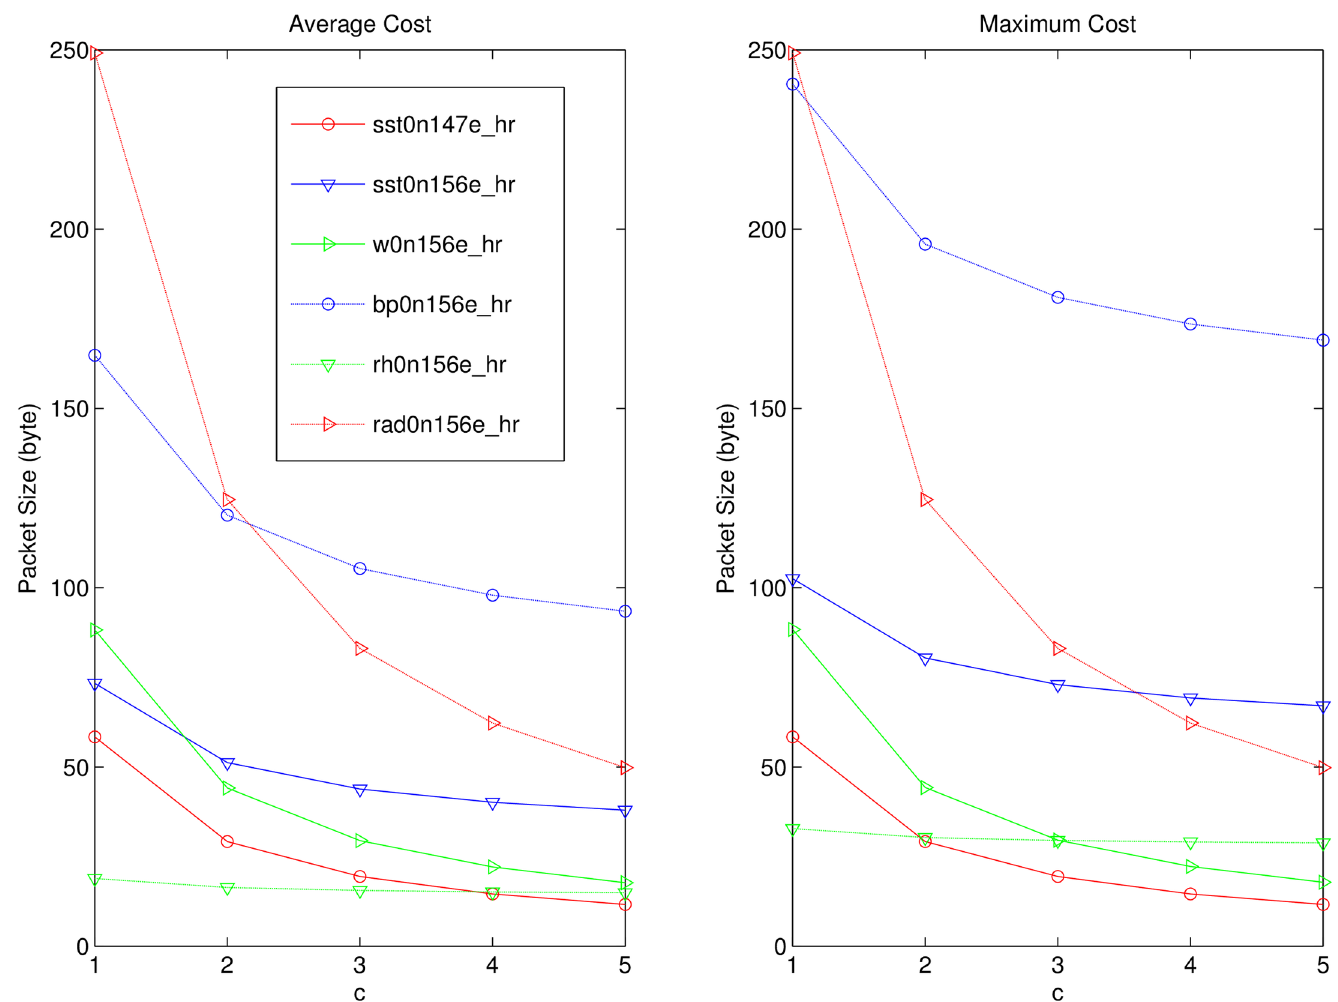
Fig 7. Cost Evaluation of